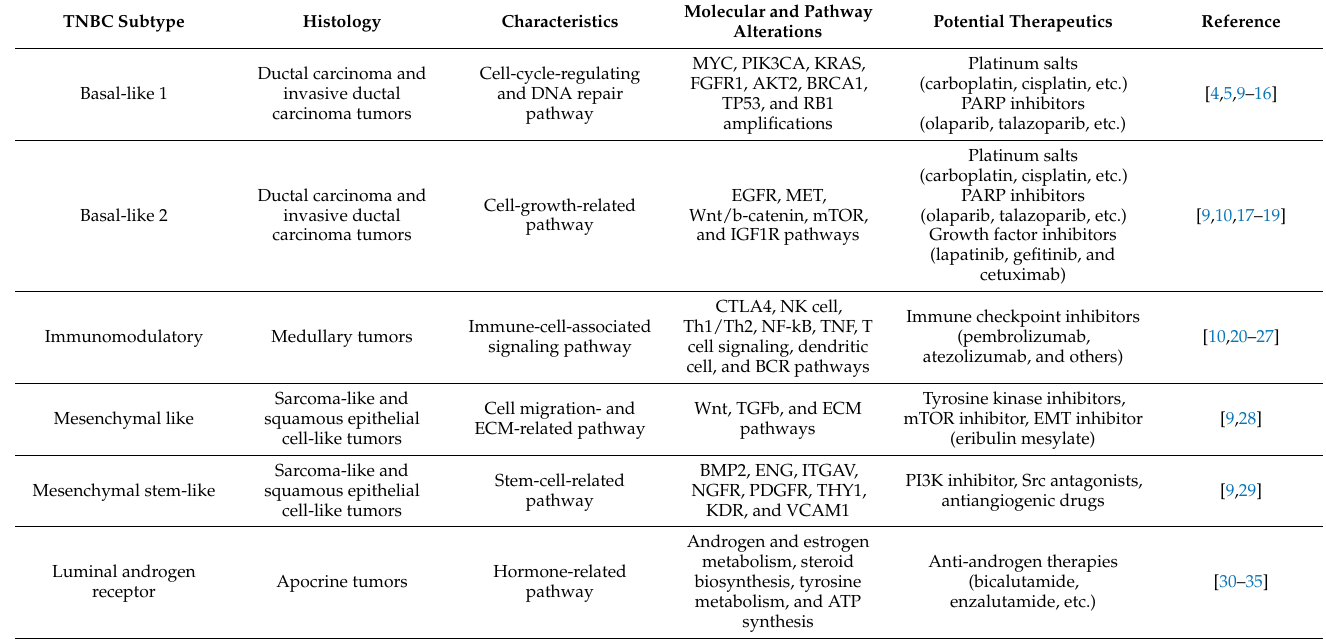
Table 1. Characteristics and potential therapies of TNBC